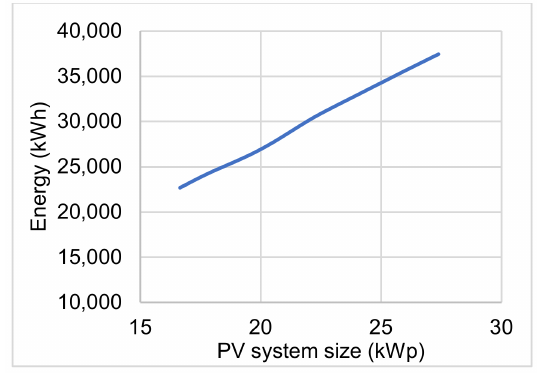
Figure 11. Generation without consumption losses.